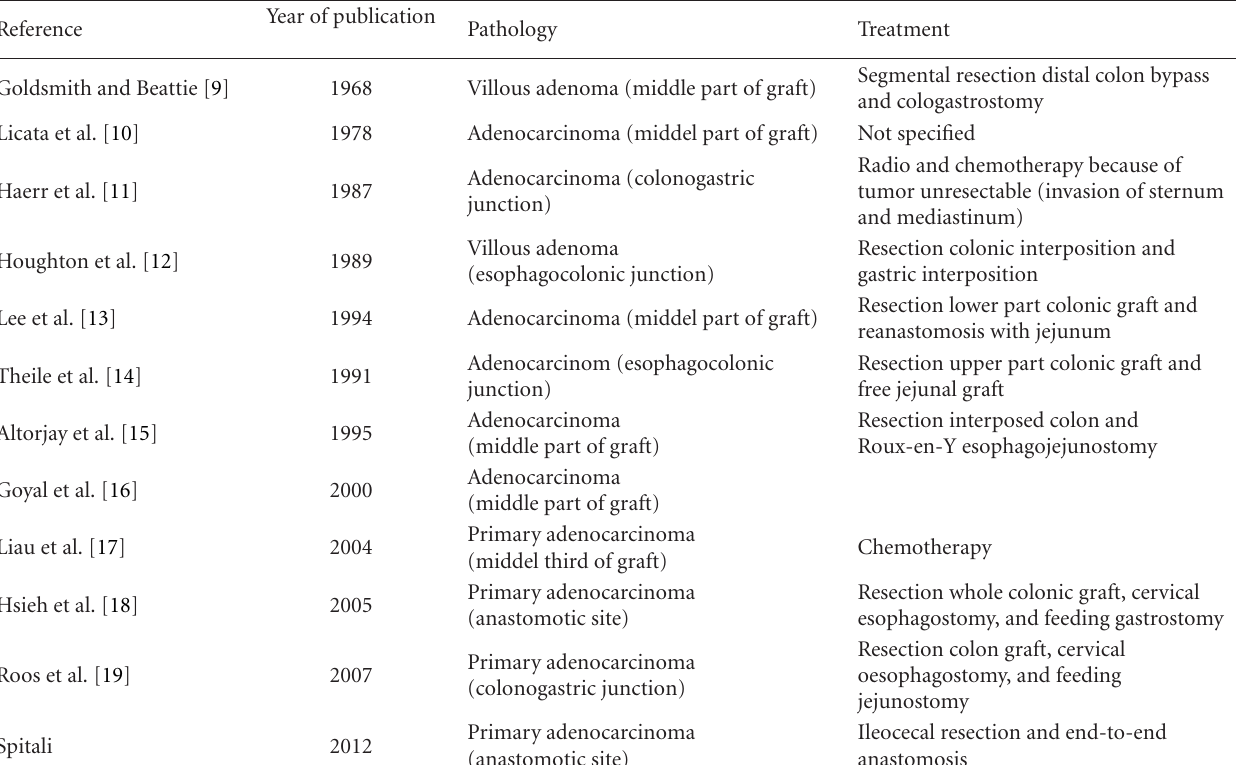
Table 2: Treatment of adenoma and adenocarcinoma at the interposed colon segments for esophageal reconstructive